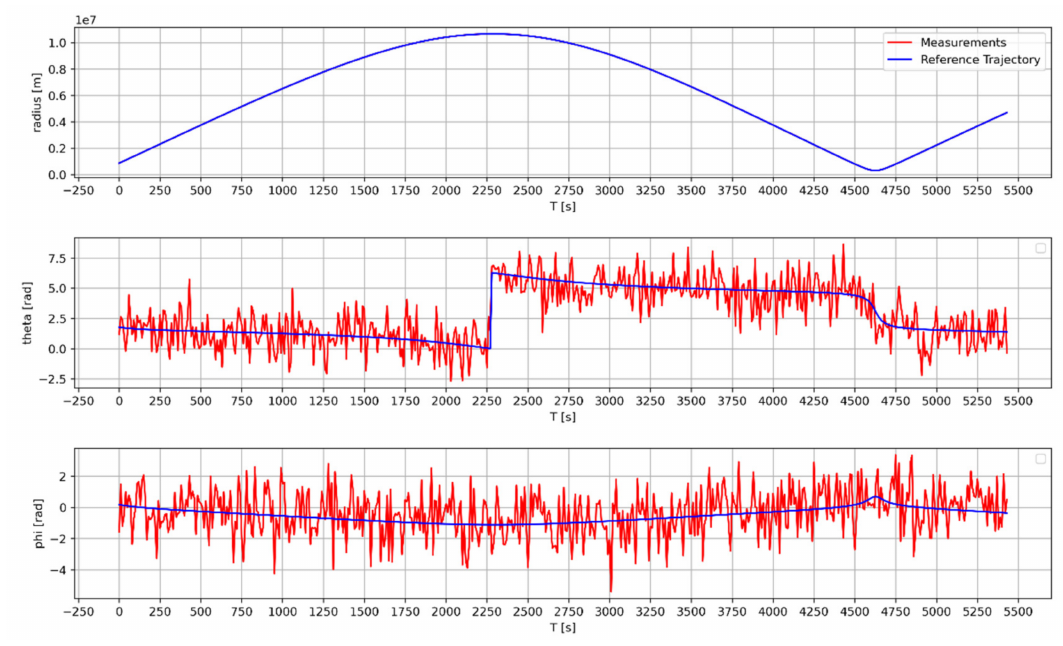
Figure 6. Radar measurements of the satellite